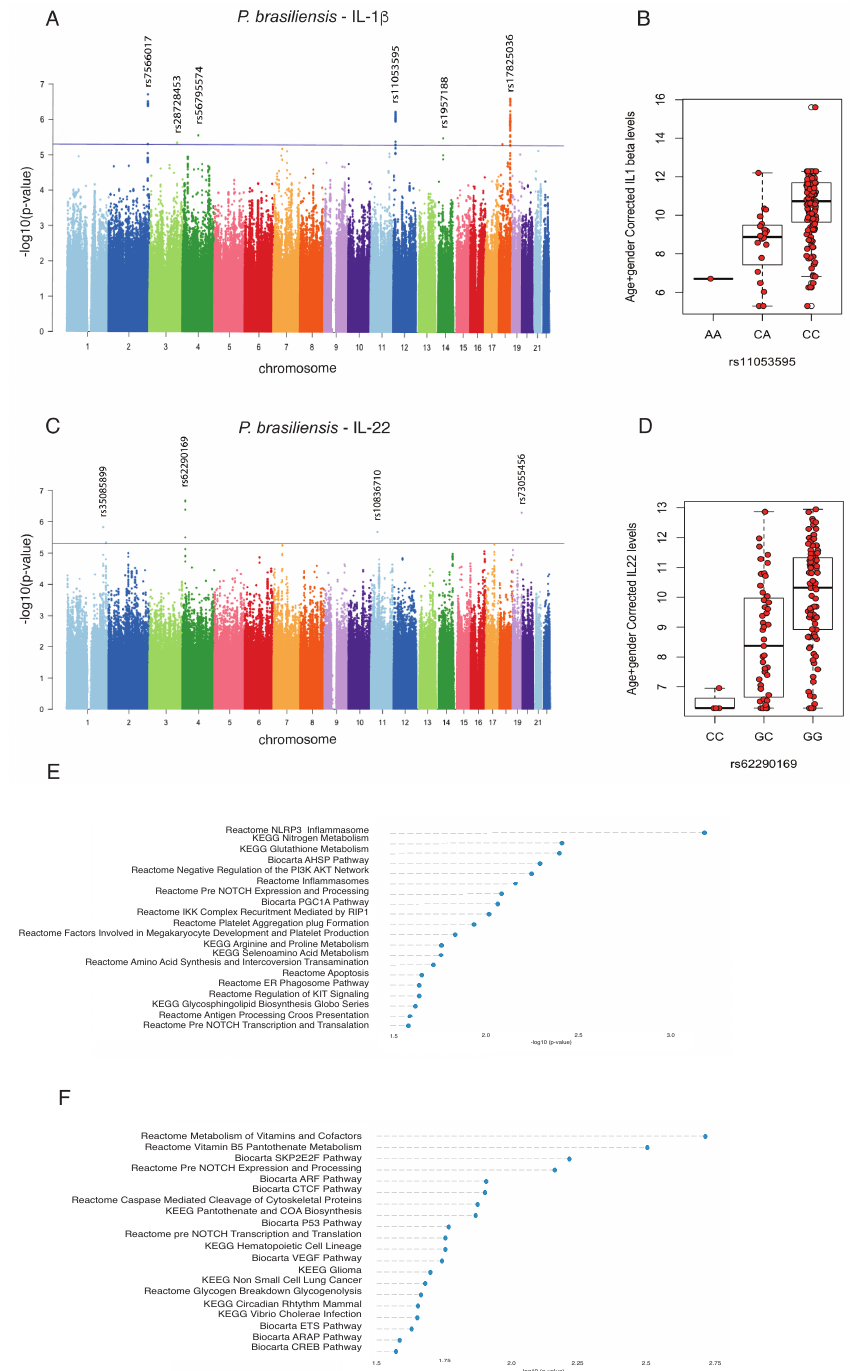
Figure 2. Genome-wide QTL mapping and association genotype with IL-1 β and IL-22 levels in- duced by Paracoccidioides brasiliensis , and enriched immune pathways. ( A , C ) Manhattan plots show- ing the cQTL mapping results for P. brasiliensis -induced IL-1 β and IL22, respectively. The y -axis represents − log10 p -values and the x -axis shows the data of each chromosome. Horizontal blue lines correspond to p -value < 5 × 10 − 6 for both IL-1 β and IL-22 Manhattan plots. ( B , D ) Log2 of age- and gender-corrected cytokine production capacity in the different genotype groups for SNP rs11053595 ( CLEC7A gene) ( p value = 1.873 × 10 − 5 ; Kruskal–Wallis test) and rs62290169 ( PROM1 gene) ( p value = 4.429 × 10 − 6 ; Kruskal–Wallis test). The data is displayed as box-plots with me- dian, quartiles with maximal and minimal values; ( E , F ) Enrichment analysis of biological pathways associated to IL-1 β and IL-22